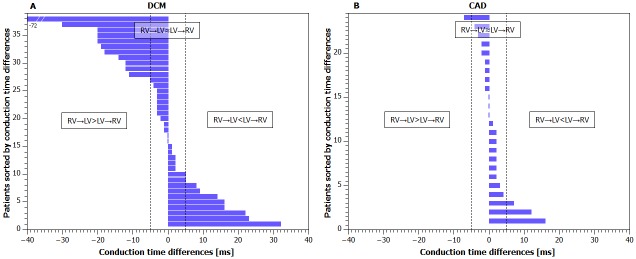
Panel A: Interventricular conduction time differences in patients sorted by its value in DCM (N = 38) group. Dashed line defines DCM subgroup borders. See Fig 1 for groups definitions. DCM patients belongs to: Group RV→LV≈LV→RV (N = 19), group RV→LV>LV→RV (N = 11), group RV→LV<LV→RV (N = 8). Panel B: Interventricular conduction time differences in patients sorted by its value in CAD (N = 24) group. Dashed line defines CAD subgroup borders. CAD patients belongs to: Group RV→LV≈LV→RV (N = 20), group RV→LV>LV→RV (N = 1), group RV→LV<LV→RV (N = 3).